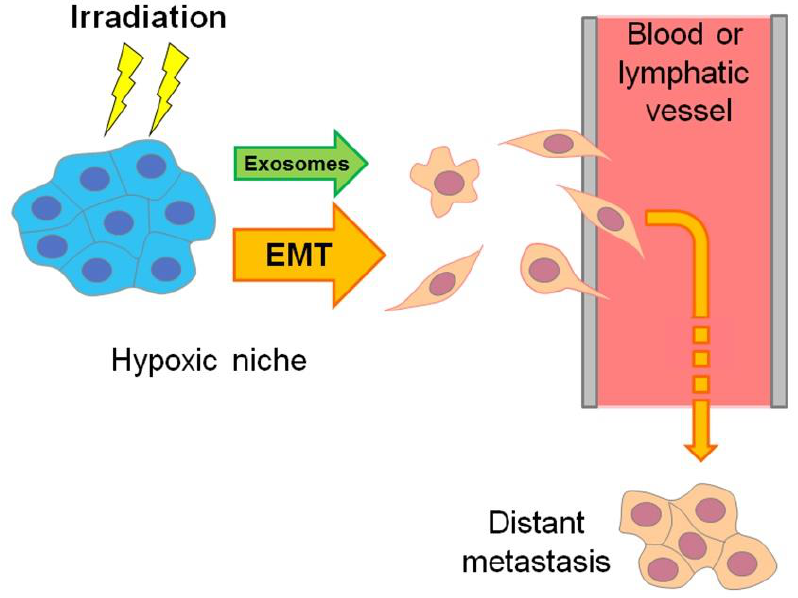
Figure 2. Scheme delineating the hypoxia-associated emergence of actively migrating invasive cancer Cells, which may flee radiotherapeutic exposure by penetrating the vasculature and forming distant metastasis. This hypoxia-driven mechanism is mainly realized through exosome generation and epithelial–mesenchymal transition (EMT) or similar phenotypic modulations toward cancer stemness (see Sections 7 and 9).